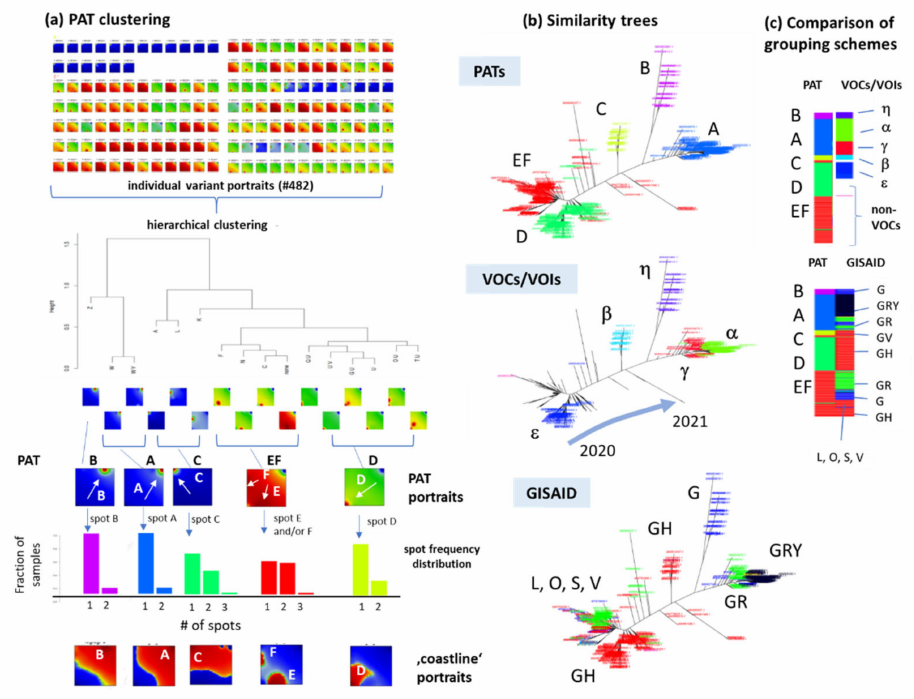
Figure 4. Pattern type (PAT) clustering and comparison with VOCs/VOIs. ( a ) PAT clustering is applied to all variant portraits to obtain five major PATs labelled by letters A–D and EF in agreement with the dominating spot(s) in each of them. Spot frequency distributions reveal that most portraits show only one spot of co-mutated SNV as indicated by the arrows. Coastline portraits use a smoother color scale to better visualize the borderline between positive (red) and negative (blue) values of the SNV score. ( b ) The PATs occupy different branches of the similarity tree, which mostly agree with classification schemes using variants of concern and interest (VOCs/VOIs) labelled by Greek letters and the GISAID clades. The temporal evolution along the tree is indicated by the arrow in correspondence to the composition dynamics shown in Figure 3b. ( c ) Pairwise mapping of the different classes illustrate their mutual